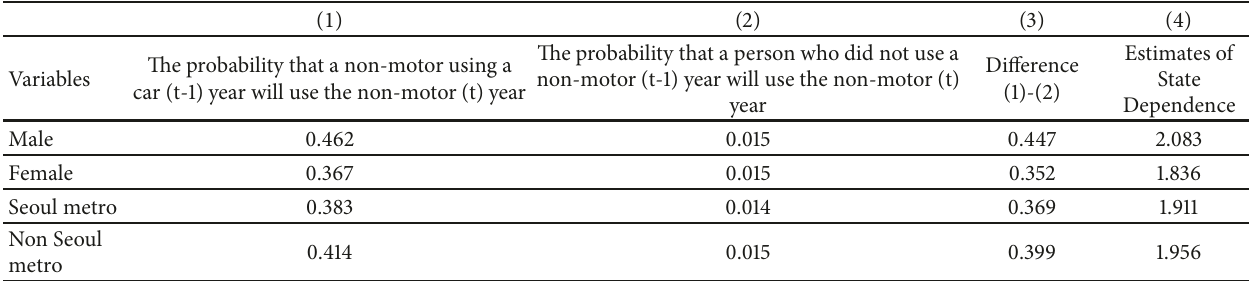
Table 11: Estimation of state dependence of nonmotorized